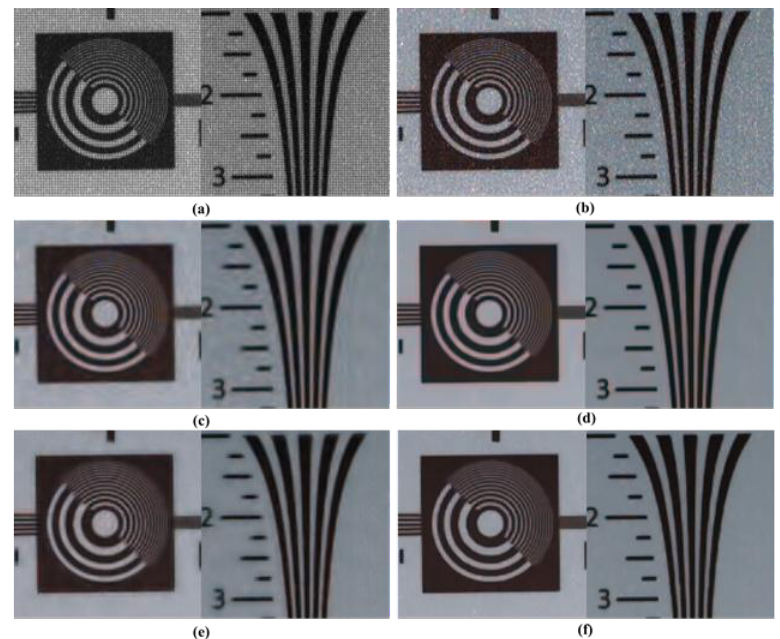
Figure 13. Partially magnified the real image. ( a ) Noisy image of Bayer pattern; ( b ) Color demosaiced image obtained by [15] for Bayer pattern; ( c ) Denoised image by method [31] with demosaicing of [15]; ( d ) Denoised image by method [9] with demosaicing of [15]; ( e ) Denoised image by method [32]; ( f ) Denoised image by proposed method with demosaicing of [15]. The numerical evaluation is presented in Tables 1 and 2 for average peak signal to noise ratio (PSNR) and color peak signal to noise ratio (CPSNR) values. Tables 1 and 2 display the average PSNR and CPSNR values of the algorithms at each noise level for the denoised results of the CFA sequence. Table 1. Average PSNR(dB) comparisons for the denoised and color interpolated results of Moving train sequence.